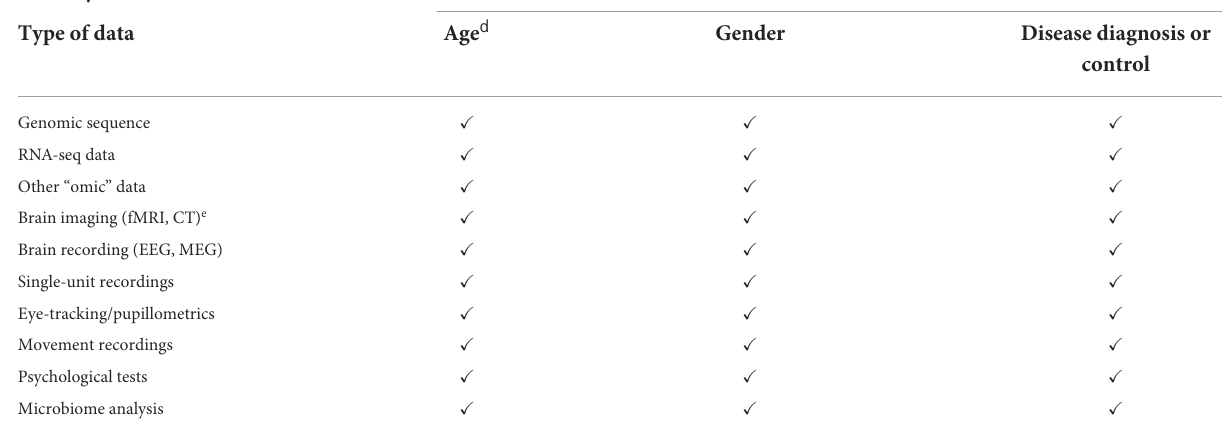
TABLE 1 Anonymized biomedical data relevant to the neurosciences that may warrant release without restrictions a,b